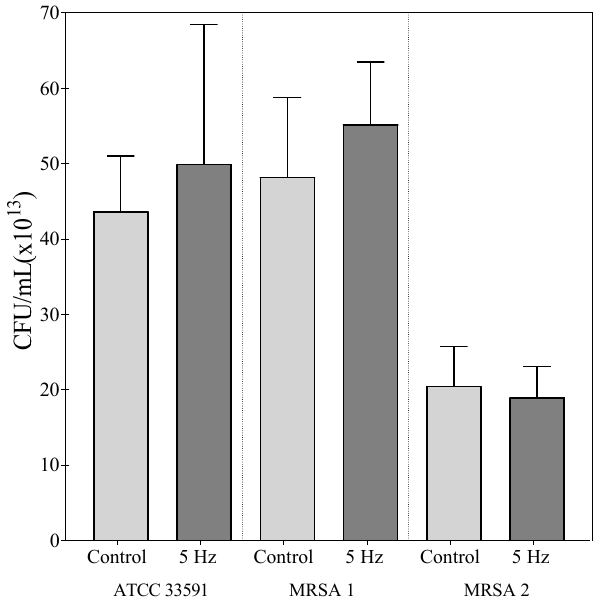
Figure 5. The number of culturable bacteria, expressed as a CFU/mL, after 12 h of RMF exposure (5 Hz) and in control, unexposed setting. The results are presented as a mean ± SEM calculated using six values (three from each biological replicate). The results show no statistically significant differences at p < 0.05.